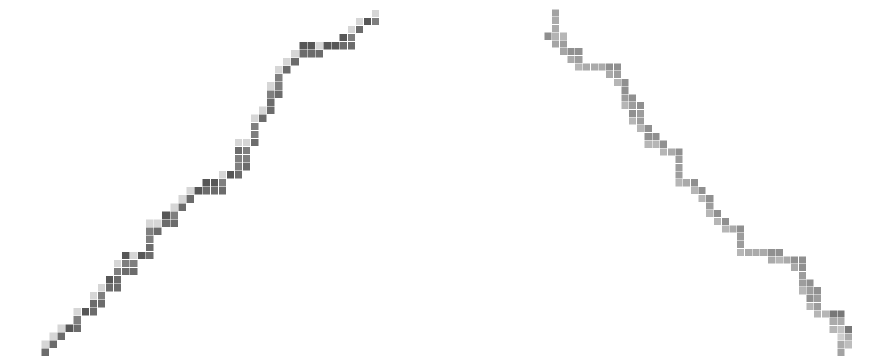
Fig. 9: Random parallelogram and convex polyominoes of area